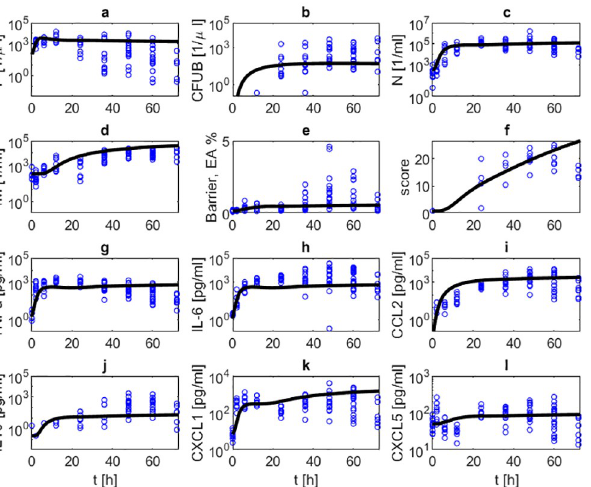
Parameter estimates resulted in a good agreement of model and data for the majority of time points. In Fig 4, the simulated time courses of pneumococcal population in BAL and blood, neutrophils and inflammatory macrophages in BAL, TNF- α , IL-6, CCL2, IL-10, CXCL1 and